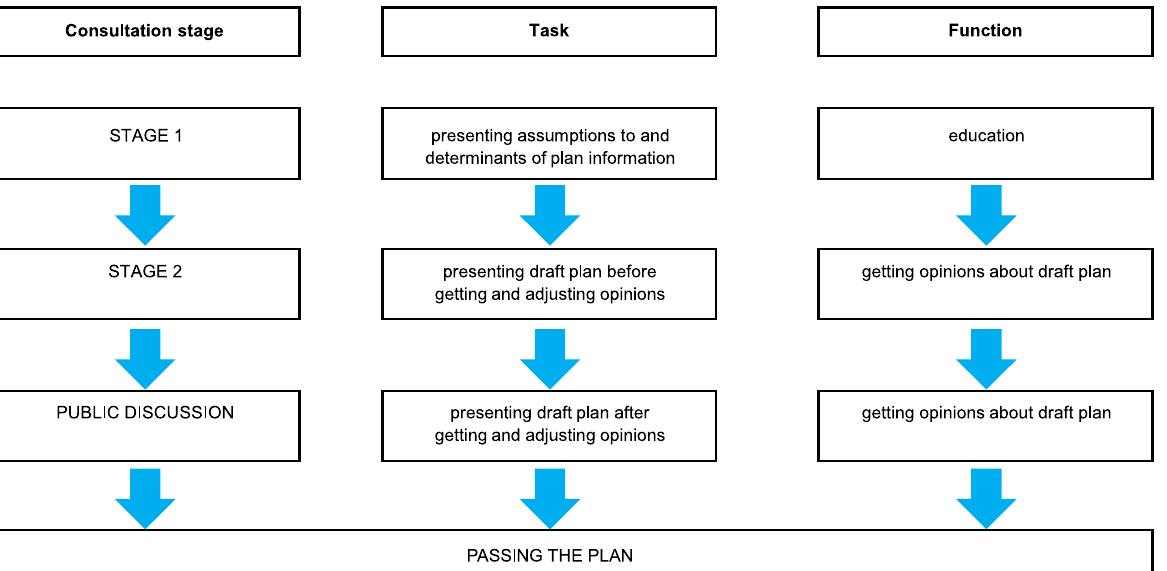
Fig. 2. Tasks and functions of public consultations in the procedure of preparing local spatial development plans in Poznań. Source: own